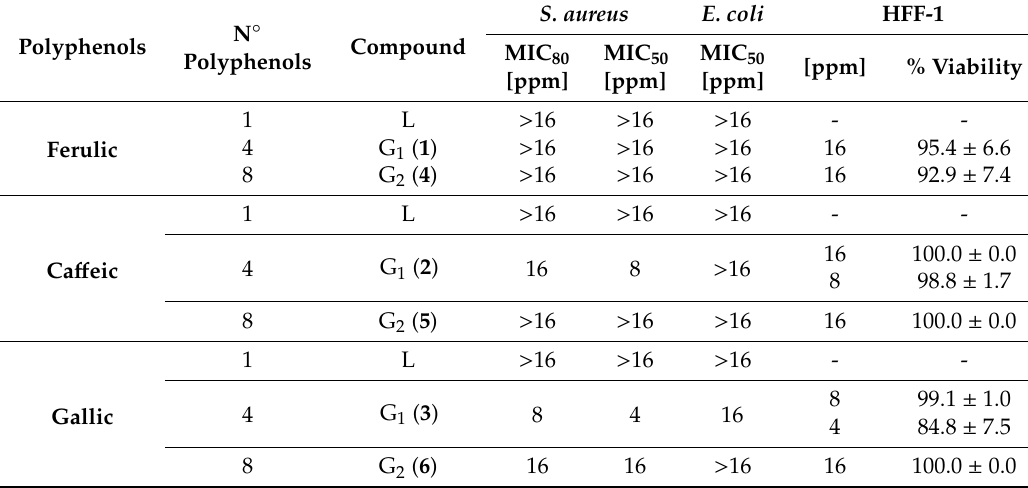
Table 2. Bacteriostatic minimum inhibitory concentration (MIC) in S. aureus and E. coli and percentage of HFF-1 cells’ viability obtained by treatment with 1 – 6